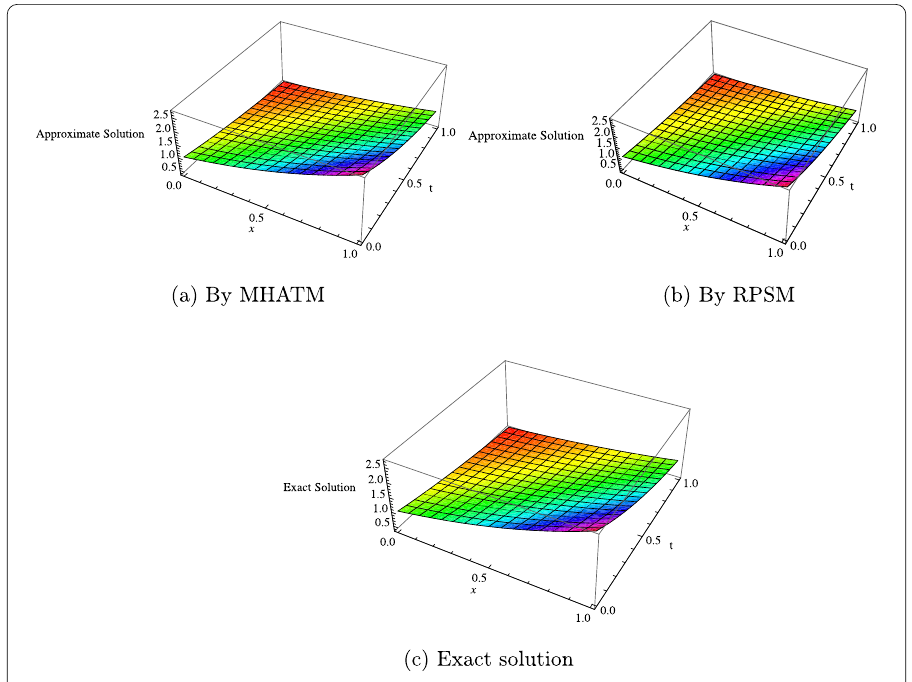
Figure 14 The surfaces show ( a ) the numerical approximate solution of η 4 ( x , t ) by MHATM when λ = 1, ( b ) the numerical approximate solution of η 4 ( x , t ) by RPSM when λ = 1, ( c ) the exact solution η ( x , t ) when λ =